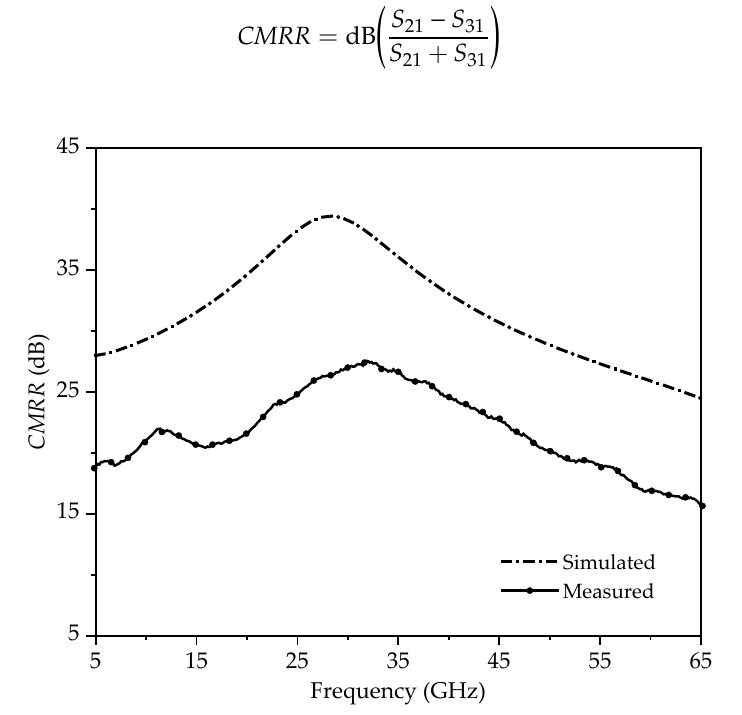
Figure 12. Simulated and measured common mode rejection ratio ( CMRR ).